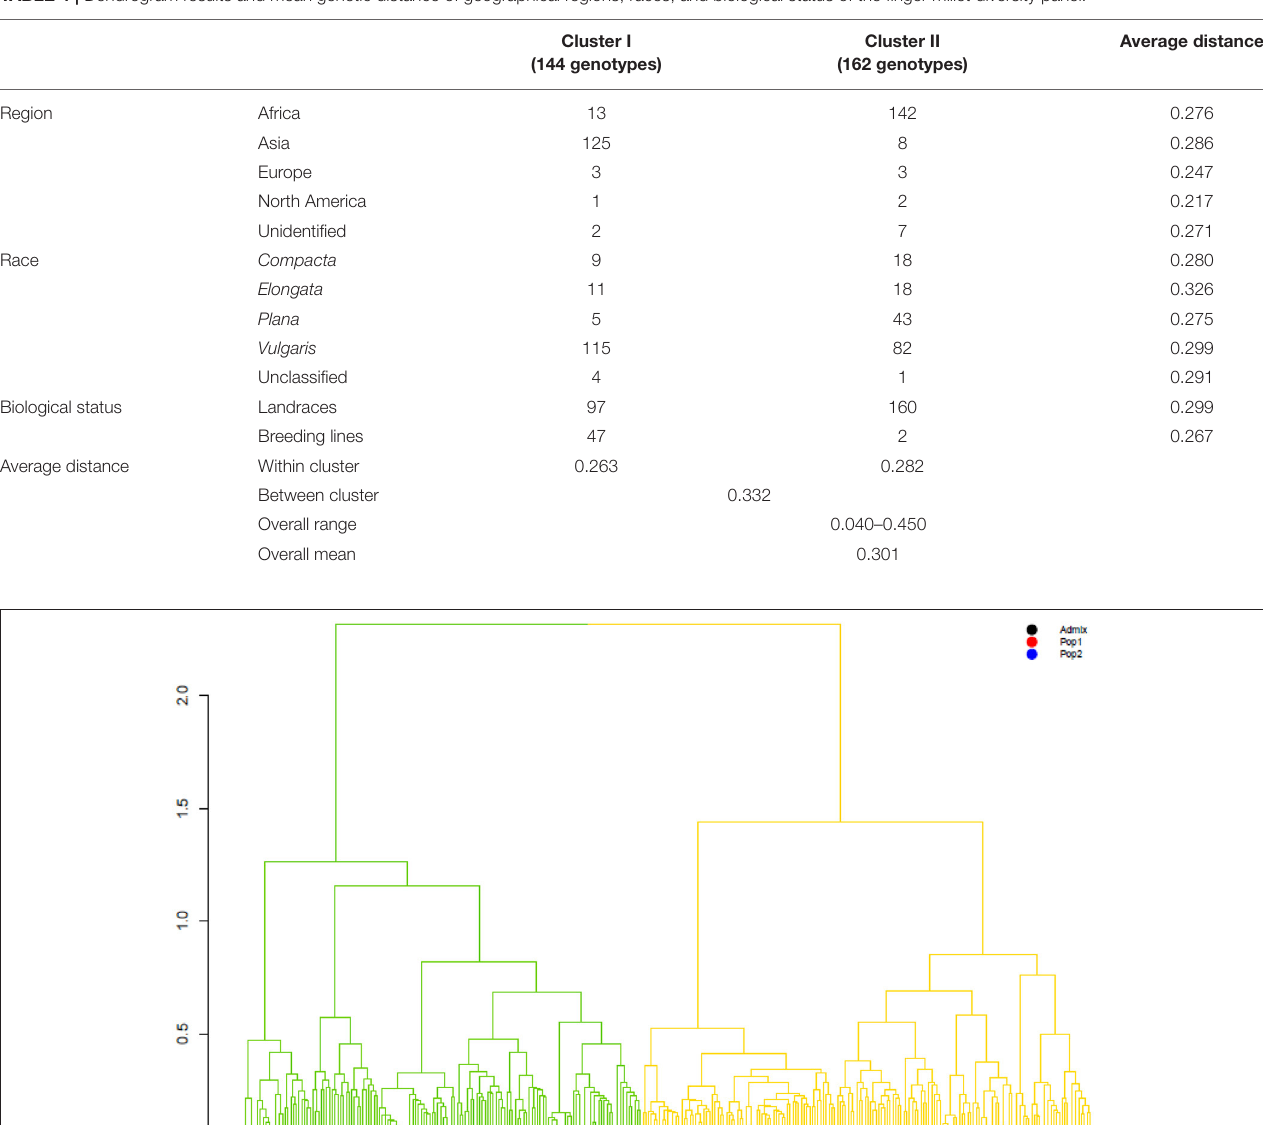
TABLE 4 | Dendrogram results and mean genetic distance of geographical regions, races, and biological status of the finger millet diversity panel.